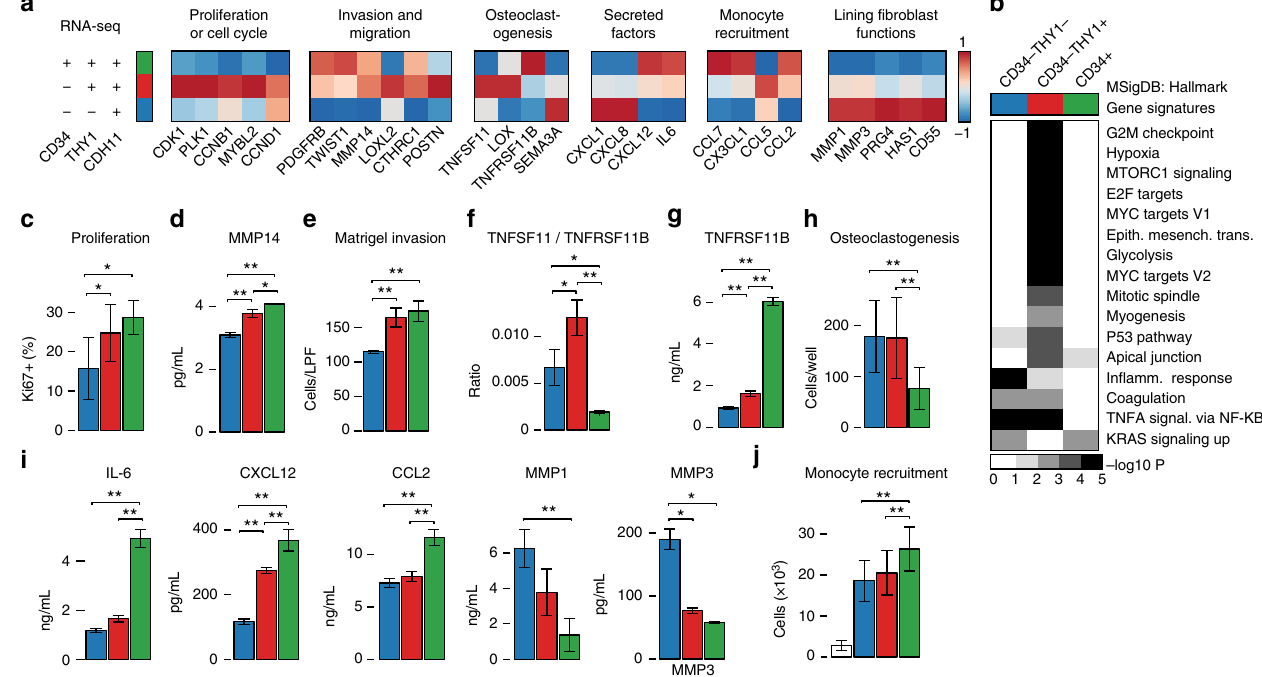
Fig. 5 Functional differences between fi broblast subsets. a Gene expression pattern of key effector molecules to predict the function of fi broblast subsets. b Gene set enrichment analysis with RNA-seq samples and MSigDB Hallmark Gene Signatures. Terms with < 5% FDR are displayed. c The proportion of Ki67-positive cells in freshly isolated synovial fi broblast subsets. d Protein expression of MMP14 in the cell lysates of expanded fi broblast subsets in the presence of 1 ng/mL TNF- α . e The number of migrated and invaded cells in transwell matrix invasion assay. Fifty nanogram per mL of PDGFBB was used to promote migration and invasion. f The ratio of TNFSF11 (RANKL) and TNFRSF11B (OPG) in mRNA level in expanded fi broblast subsets. g Protein expression of TNFRSF11B in the supernatant of expanded fi broblast subsets. h Number of osteoclasts developed in the co-culture of osteoclast progenitors with fi broblast subsets in the presence of 20 ng/mL M-CSF and 5 ng/mL RANKL. i Protein expression of cytokines and MMPs in the supernatant of expanded fi broblast subsets in the presence of 1 ng/mL TNF- α . j The number of migrated monocytes in monocyte recruitment assay using supernatant of cultured fi broblast subsets. In bar graphs, blue, red and green color coding corresponds to the fi broblast subsets shown in a . White bar in j indicates culture media without fi broblasts. Bars show means and error bars show standard deviations. One-way ANOVA, Tukey's post hoc: * P < 0.05; ** P <